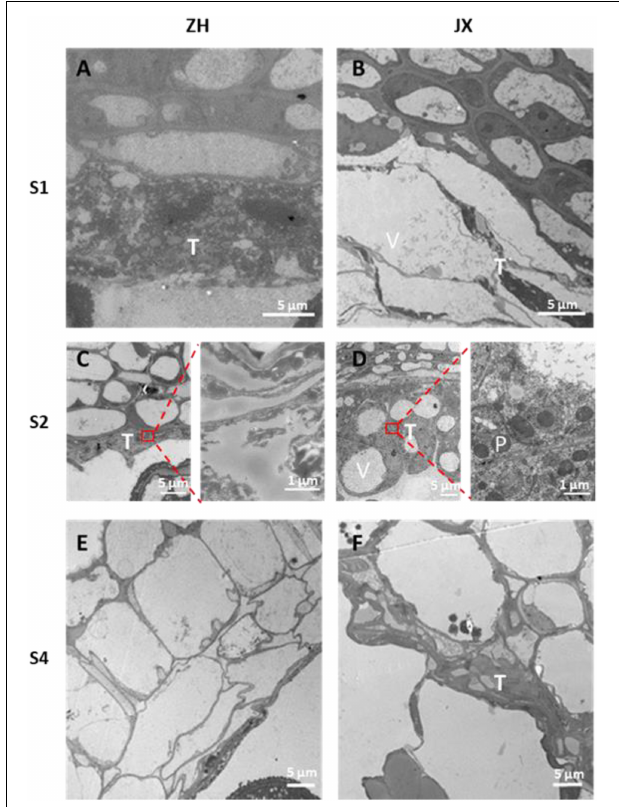
FIGURE 5 | Transmission electron microscopy scans of tapetum morphology in “ZH” and “JX.” (A) Normal tapetum; (B) vacuolized tapetum; (C) degraded tapetum; (D) swollen tapetum; (E) completely degraded tapetum; (F) delayed tapetum degradation. T, tapetum; V, vacuole; P,